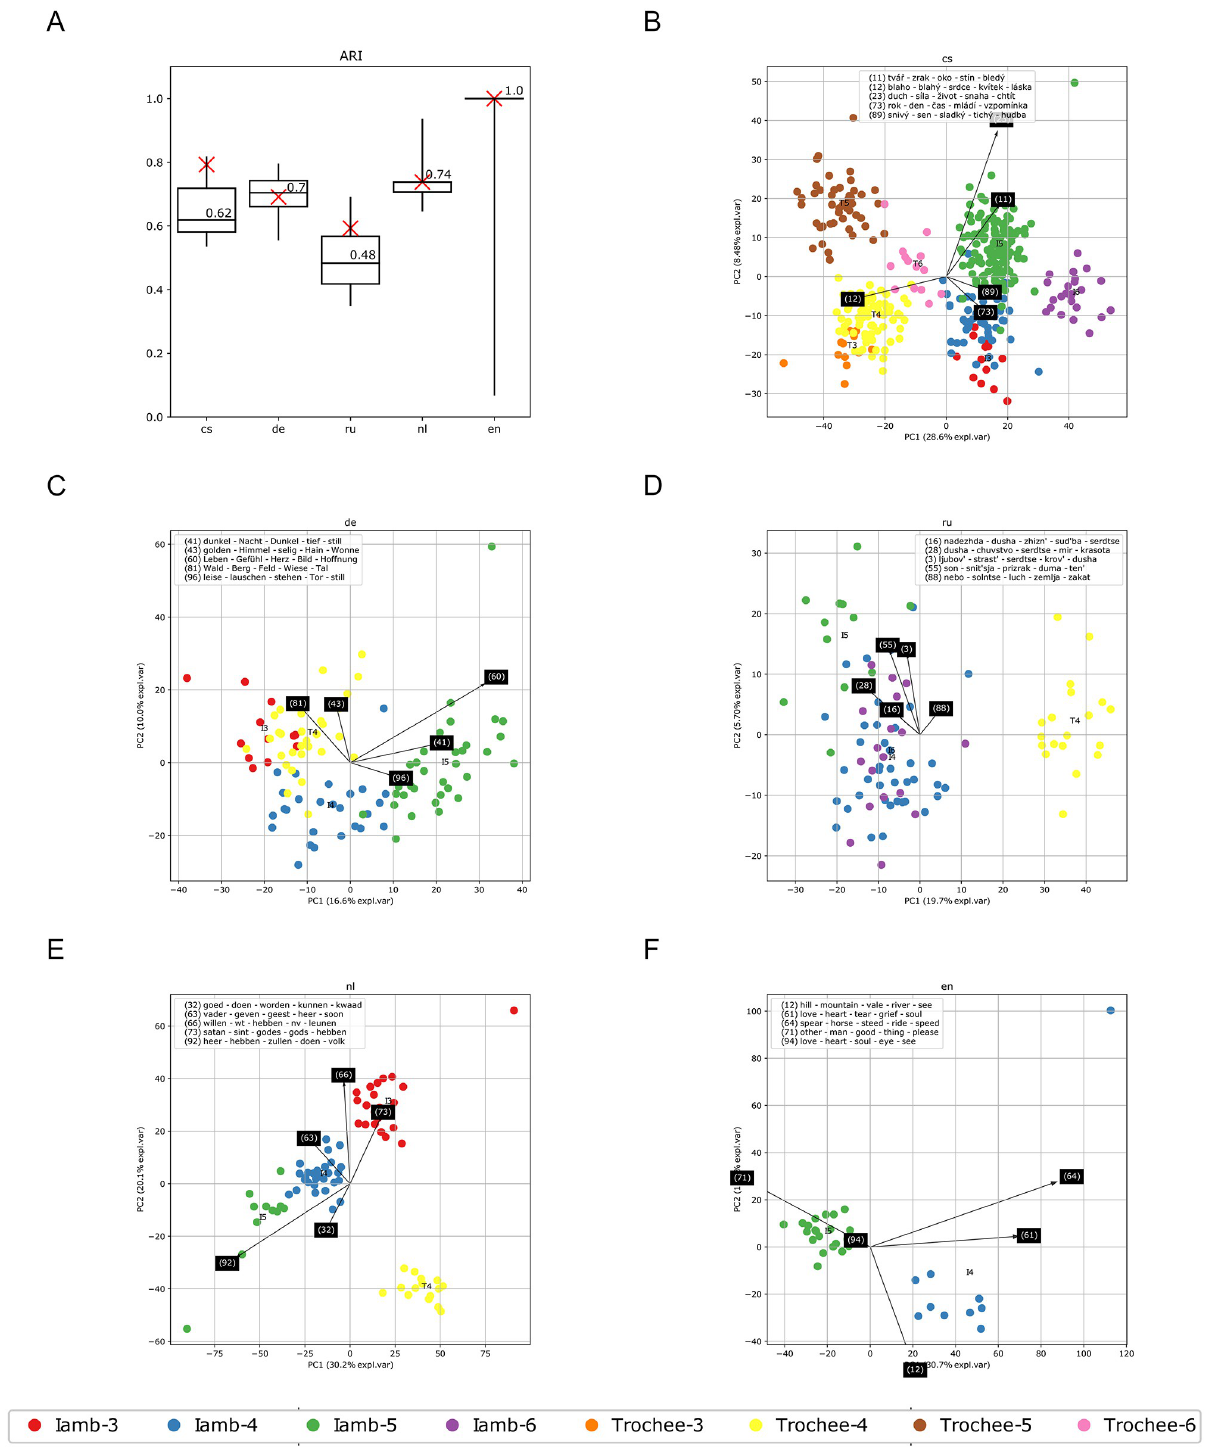
Fig 1. Random 100-poem samples taken without replacement per meter in vector spaces defined by LDA topic models. (A) Adjusted Rand Index of k -means clustering (whiskers give the 5th- to 95th-percentile range). 10,000 random samplings. Crosses show the ARI of the samplings presented in PCA biplots. PCA biplots of (B) Czech (8 meters), (C) German (4 meters), (D) Russian (4 meters), (E) Dutch (4 meters) and (F) English data (2 meters) respectively with eigenvectors for the 5 most contributing topics. Single random sampling.